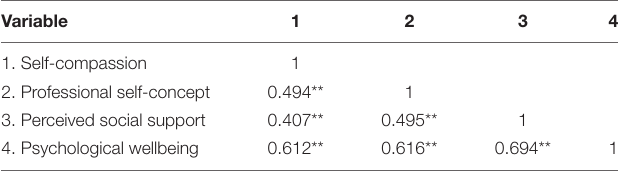
TABLE 2 | Correlations for all